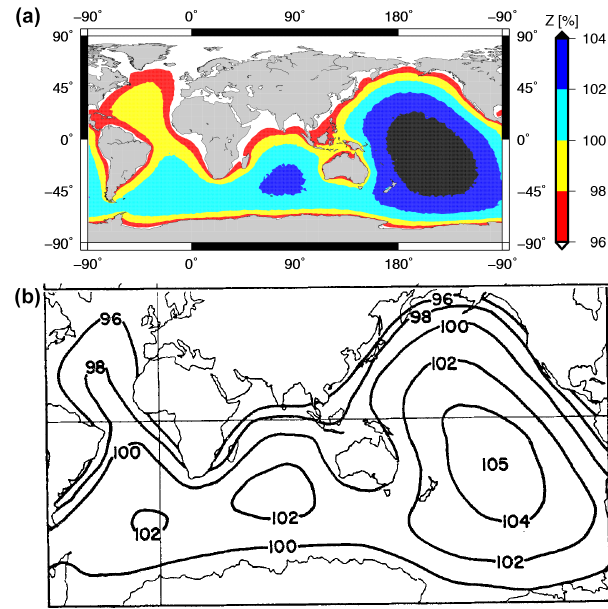
Figure B1. Change in relative sea level neglecting ice loads on an elastic non-rotating earth. Normalized sea level with respect to global mean value (see Eq. B1), (a) computed by ISSM-SESAW and (b) provided by Farrell and Clark (1976) in their Fig.